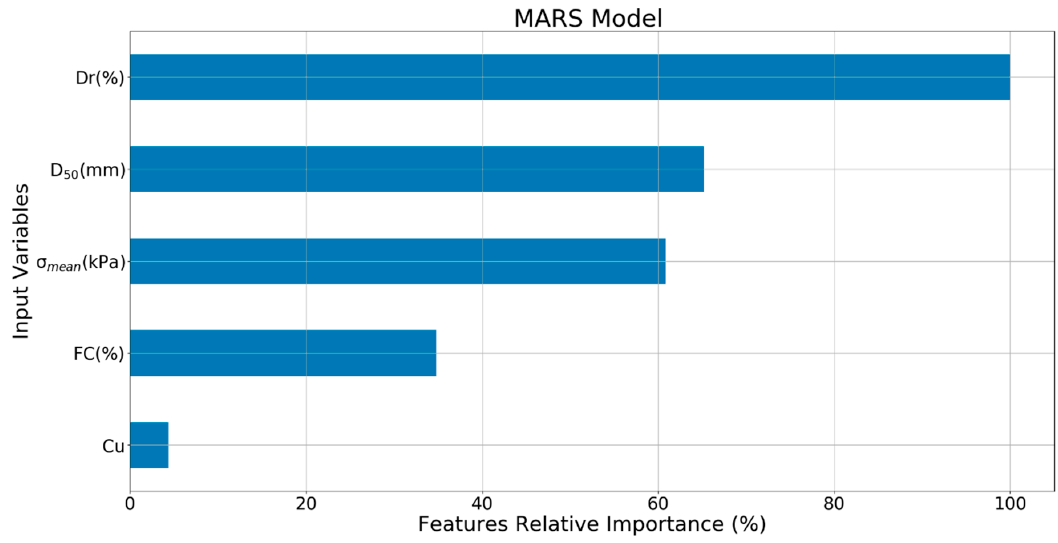
Figure 32. Relative importance of the input variables for the developed MARS model.